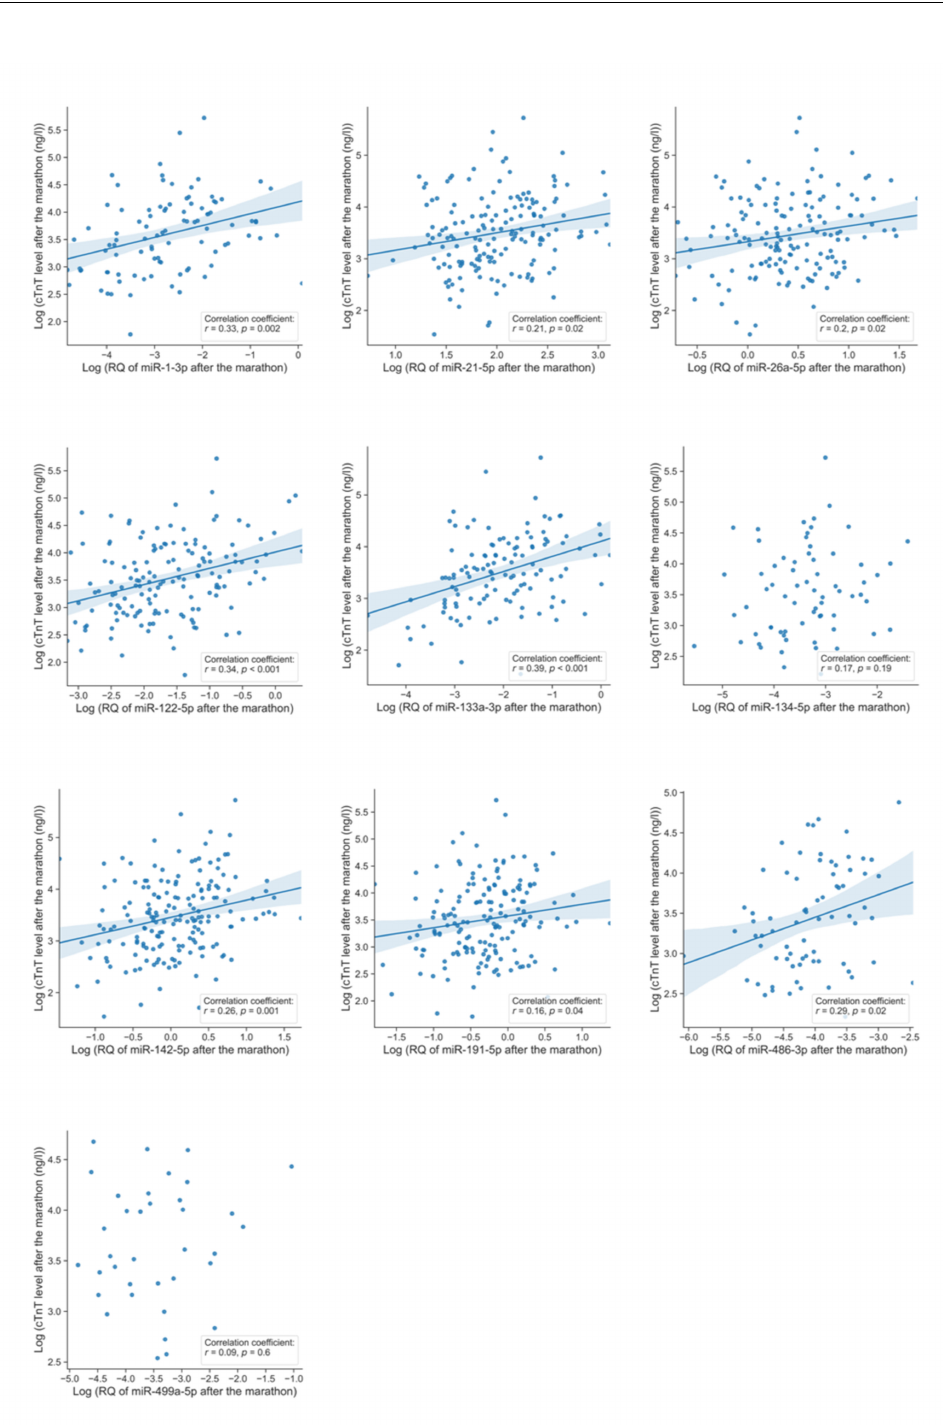
Figure 3. Pearson’s correlation coefficient of microRNAs and cardiac troponin T after the marathon. Pearson’s correlation coefficient was performed on relative quantities of microRNA expressions after the marathon and cTnT concentrations after the marathon of runners. Eight microRNAs present significant positive correlations. The highest correlation coefficient belongs to miR-133a-3p with r = 0.39. Natural log transformation was performed on data. Linear regression line and 95% confidence interval (blue area around the regression line) are plotted for significant correlations. Adjustment of p -values for multiple testing was performed based on false discovery rate according to Benjamini and Hochberg. MicroRNA expressions were attained by means of quantitative real-time polymerase chain reaction. Abbreviations: cTnT, cardiac troponin T; r, correlation coefficient; RQ, relative